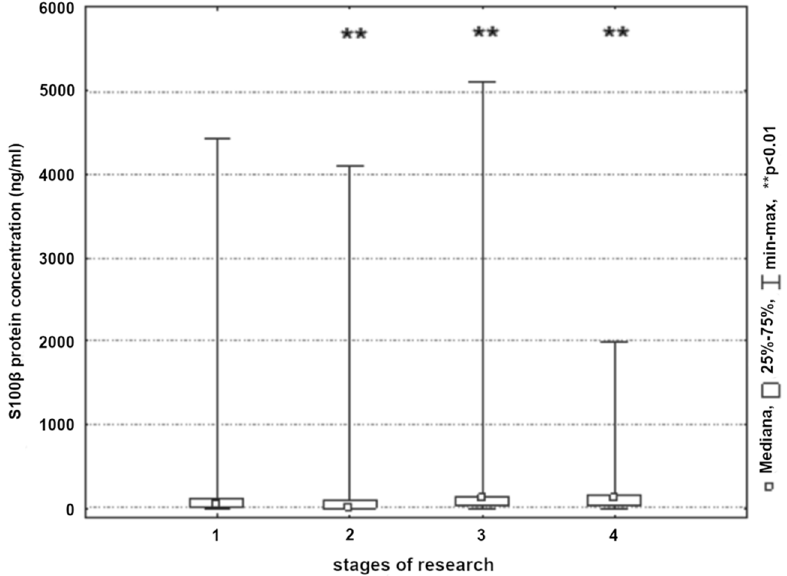
Figure 9. S100 β protein concentration in patients in the next stages of research (1, 24 h before surgery; 2, 8 h post-surgery; 3, 24 h post-surgery; and 4, 48 h post-surgery).